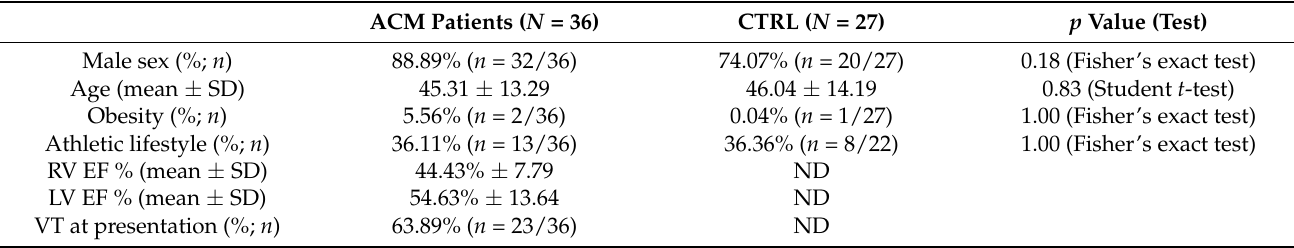
Table 1. Demographic and clinical characteristics of enrolled subjects. ACM, arrhythmogenic cardiomyopathy; RV, right ventricle; LV, left ventricle; EF, ejection fraction; VT, ventricular tachycardia. Data are reported as percentages (%) or mean ± standard deviation